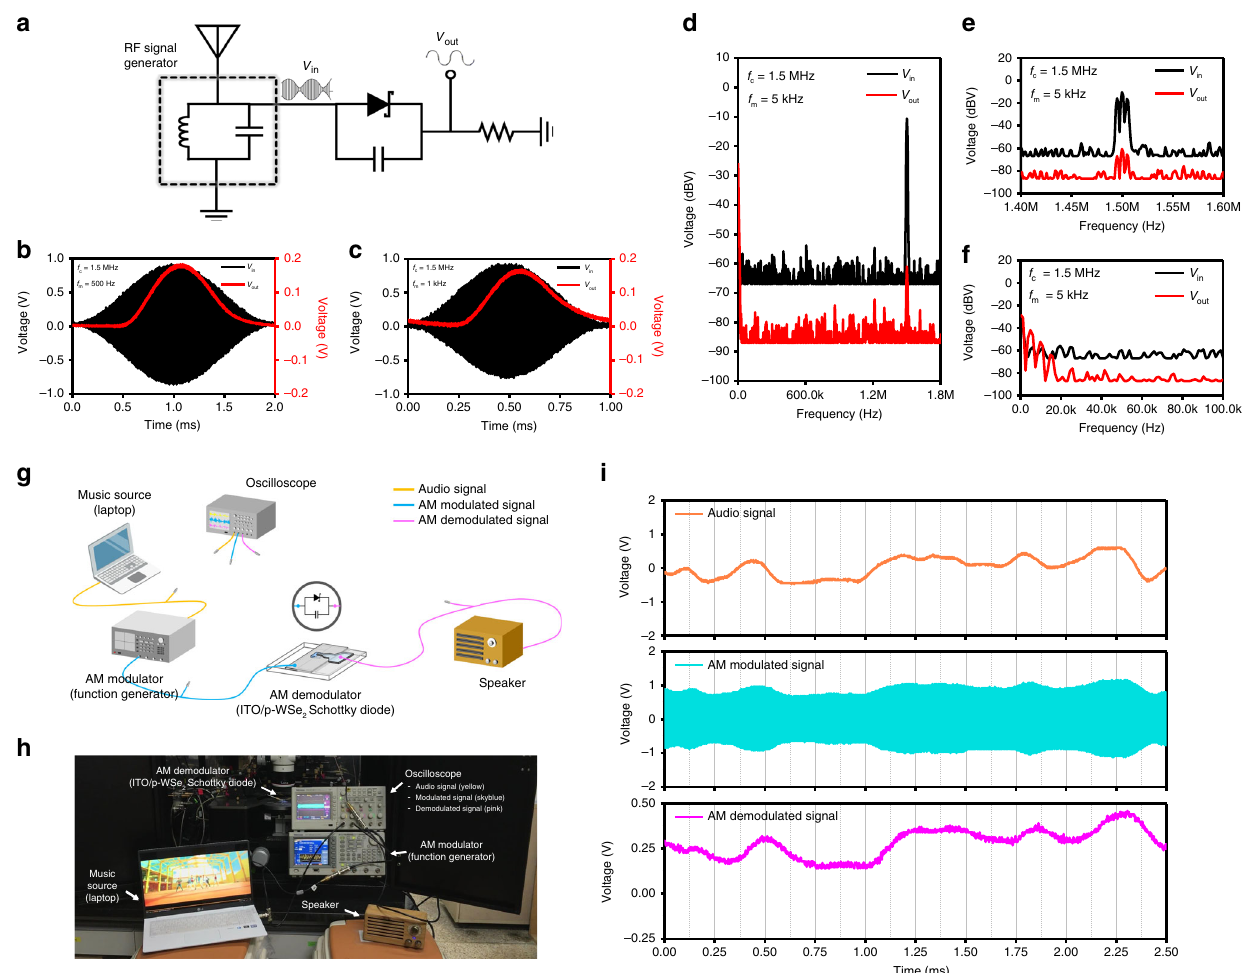
Fig. 2 AM radio receiver. a Schematic circuit diagram of AM radio receiver including an antenna. Amplitude modulated input (black) and demodulated output (red) voltage signals in time domain spectra as obtained at f c = 1.5 MHz with f m = 500 Hz ( b ) and 1 kHz ( c ). d Fast fourier transform (FFT) input (black) and output (red) spectra in frequency domain at f c = 1.5 MHz with f m = 5 kHz. e Zoomed FFT spectra for symmetric baseband which consists of three fi ne peaks at 1.5 MHz and ±5 kHz apart from the central 1.5 MHz (carrier feed-through signal peak). They also show much reduced AM input, which indicates demodulation effects. f Zoomed FFT spectra near 5 kHz, showing main peaks of demodulated signals at 0 Hz and 5 kHz along with distortion- induced small signals at 10 and 15 kHz. Schematic illustration ( g ) and photograph ( h ) of practical AM demodulator setup to test our Schottky device performance as composed of audio source (laptop computer), three channel oscilloscope, AM modulator (function generator), AM demodulator (ITO/p- WSe 2 Schottky diode circuit), and speaker. i Three different pro fi les from real audio (yellow), AM modulating function generator (sky blue), and demodulation (pink) signals. Note that the demodulated signals quite resemble those of real audio as an envelope of AM signals. Supplementary Fig. 10 would explain